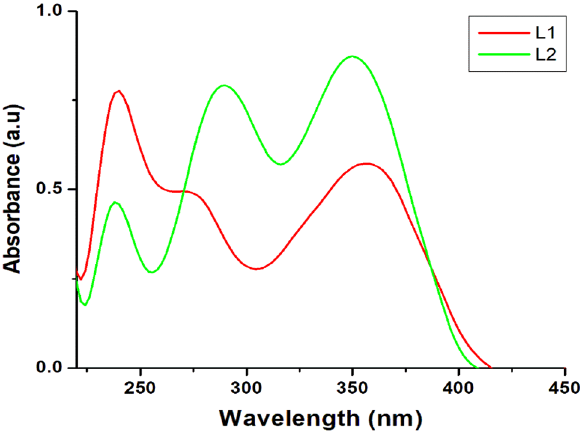
Figure 2. The electronic absorption spectra of the ligands obtained in dichloromethane.